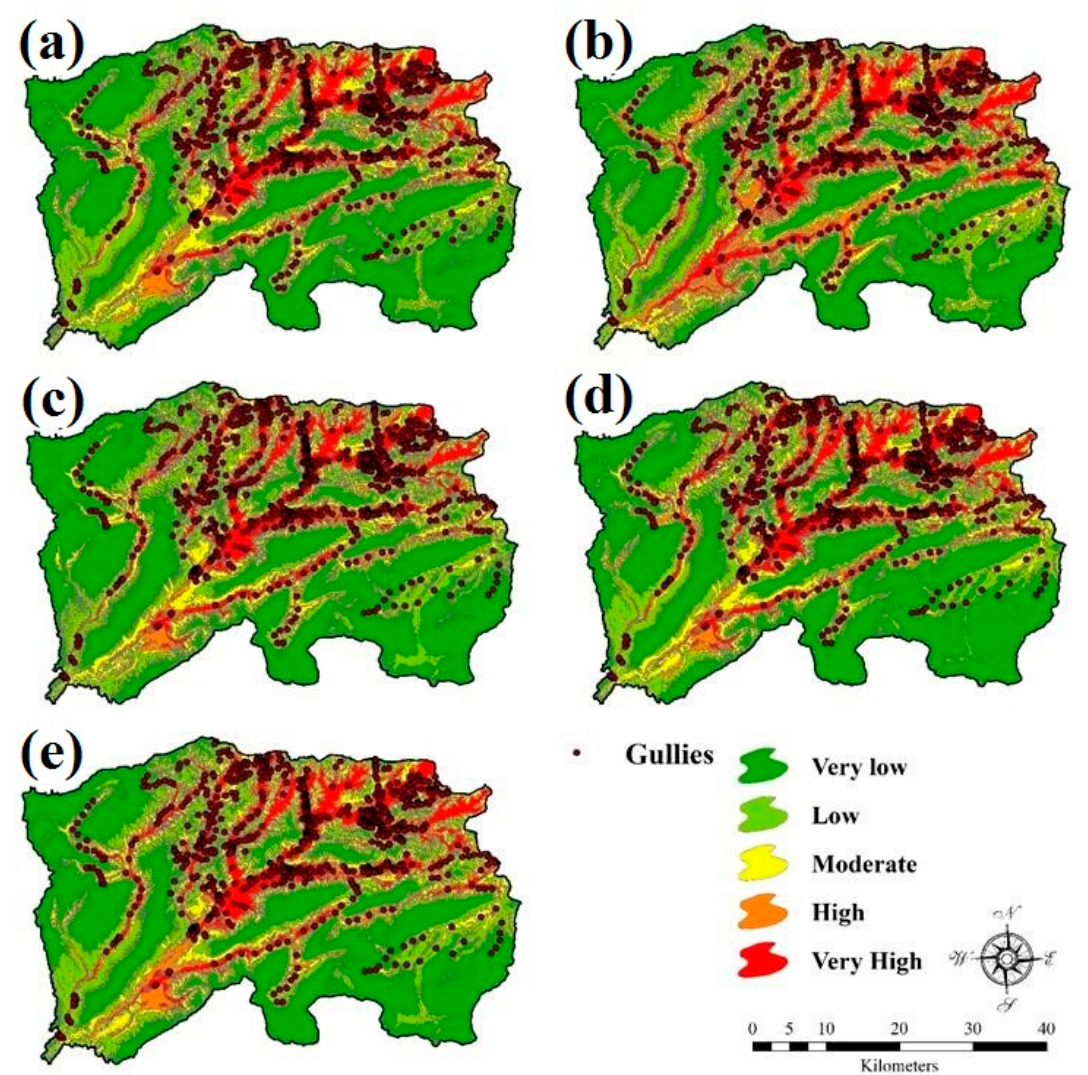
Figure 7. Gully erosion susceptibility mapping using ensemble of three and four models: ( a ) GLM-MaxEnt- ANN, ( b ) GLM-MaxEnt-SVM, ( c ) MaxEnt-ANN-SVM, ( d ) ANN-SVM-GLM, and ( e )